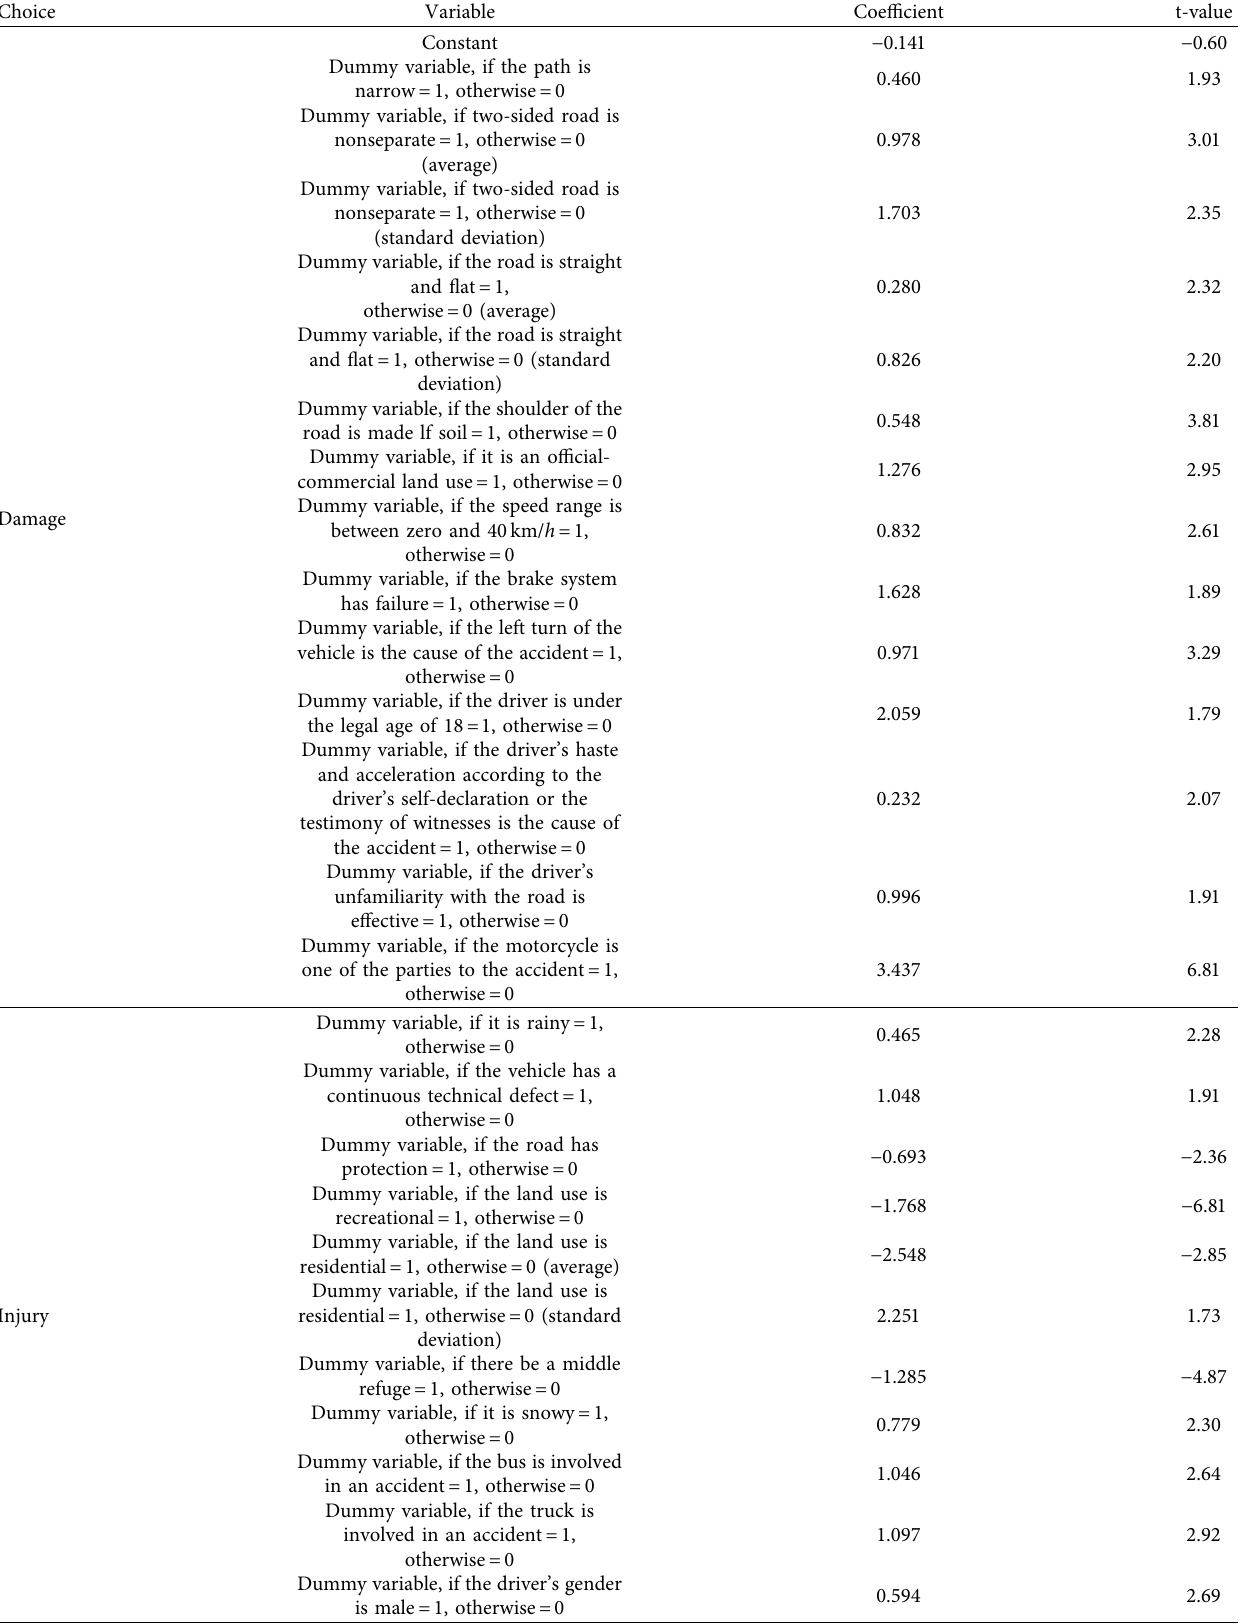
Table 5: Calibration result of mixed logit